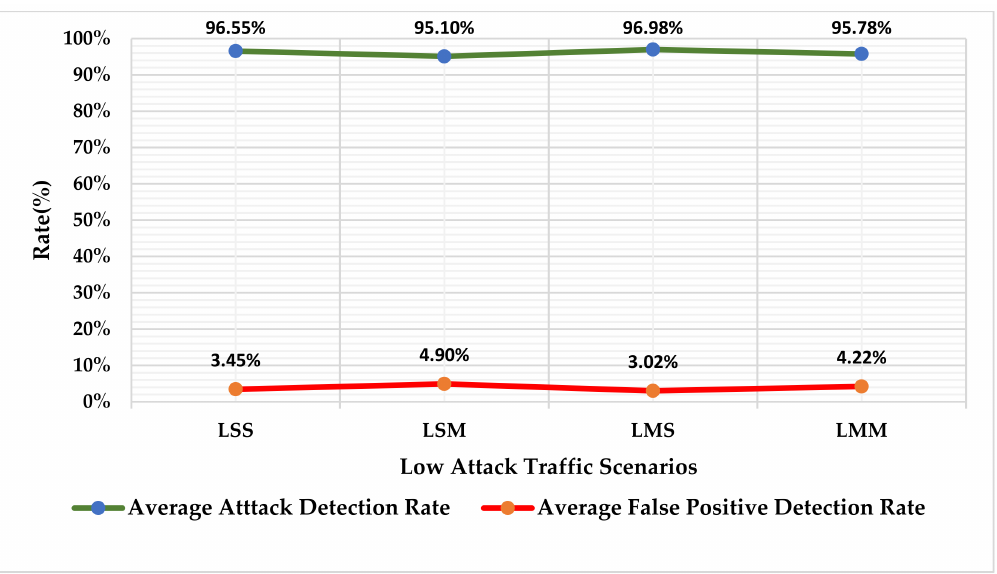
Figure 4. Average DR and FPR of each low-rate DDoS attack traffic